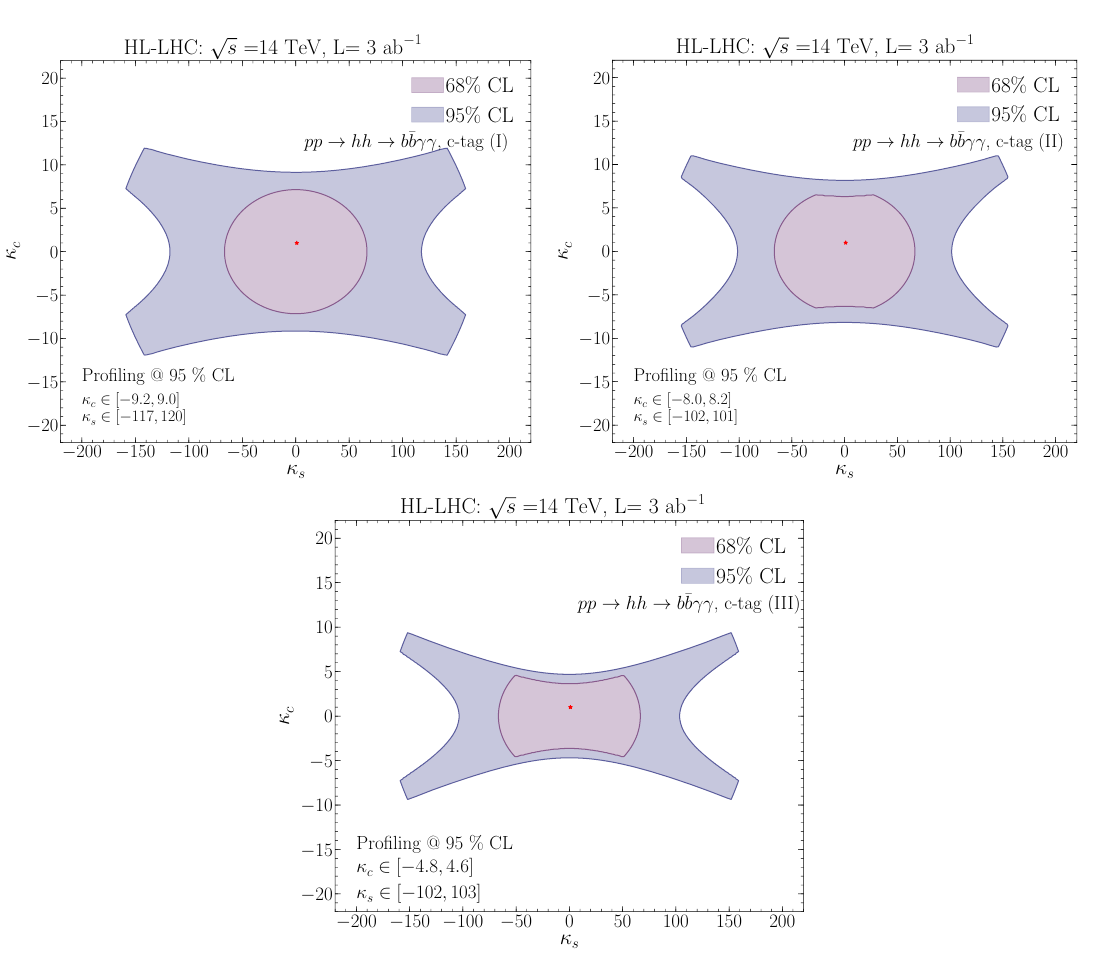
Figure 17 . The expected sensitivity likelihood contours at 68% CL and 95% CL for an integrated luminosity L = 3000 fb (cid:0) 1 for modi(cid:12)ed second generation quark Yukawa couplings, using the c- tagging I ( upper pannel, left ), II ( upper pannel, right ) and III ( lower pannel ) working points. bounds on (cid:20) do not just correspond to the scaling of the Yukawa coupling, but also to the q new coupling g arising in hhqq